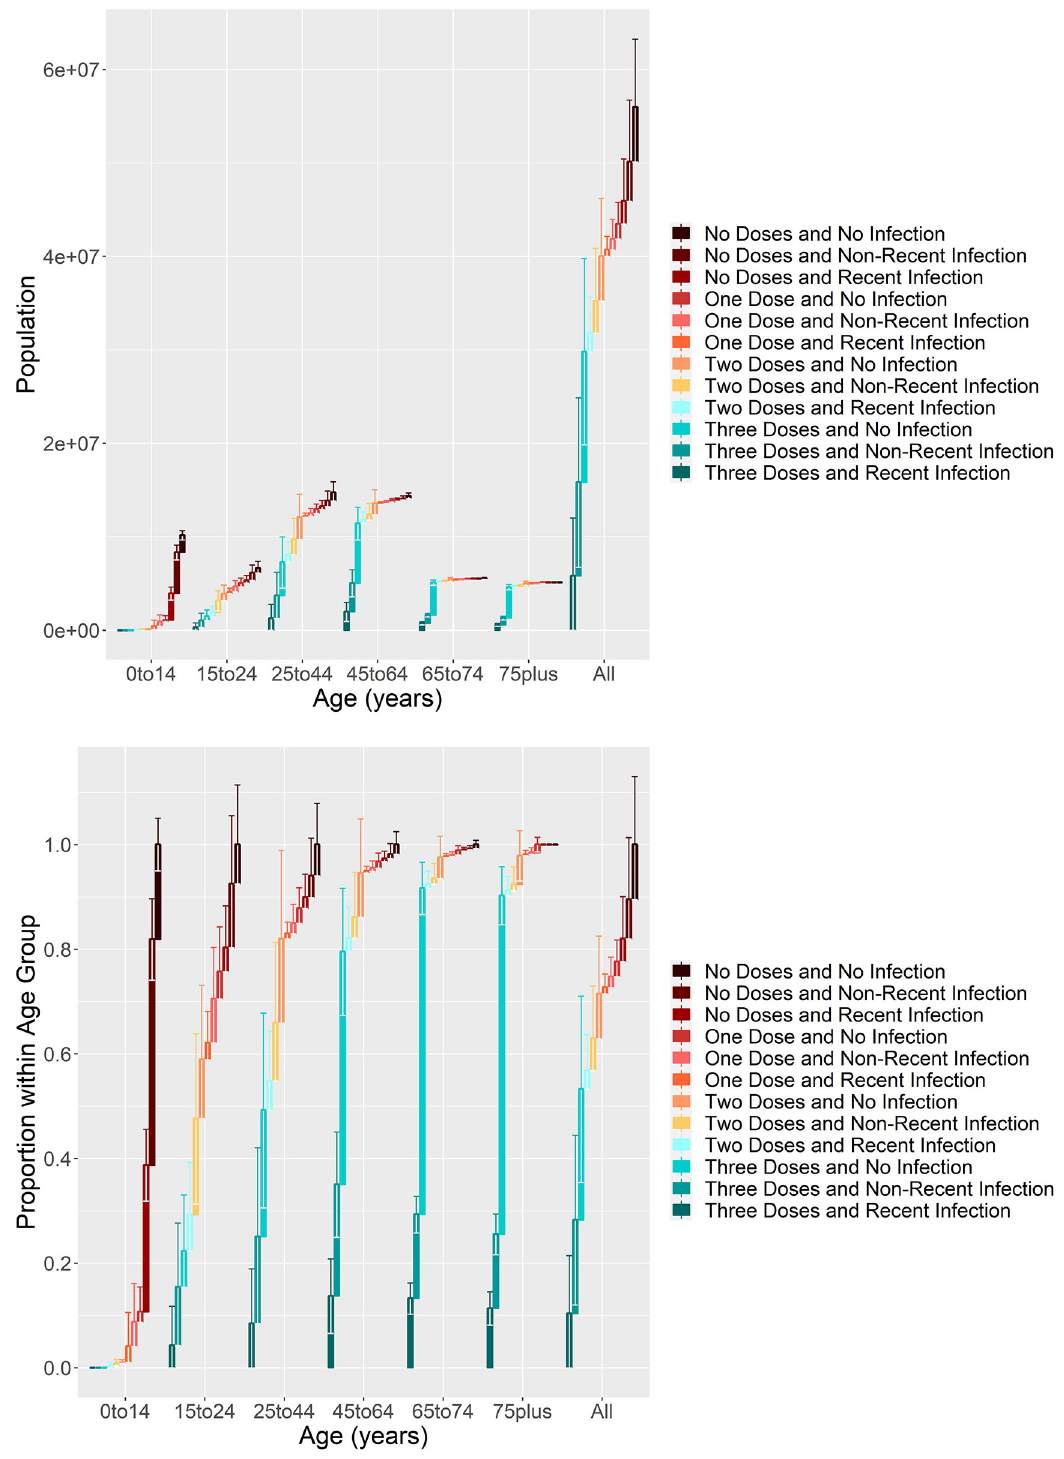
Fig 1. Immunological profiles across six age groups in England in January 2022. (a) and (b) show the absolute and proportional vaccination and infection profiles as of 12th of January 2022, respectively. The whiskers at the top of each bar indicate the 95% confidence interval of the